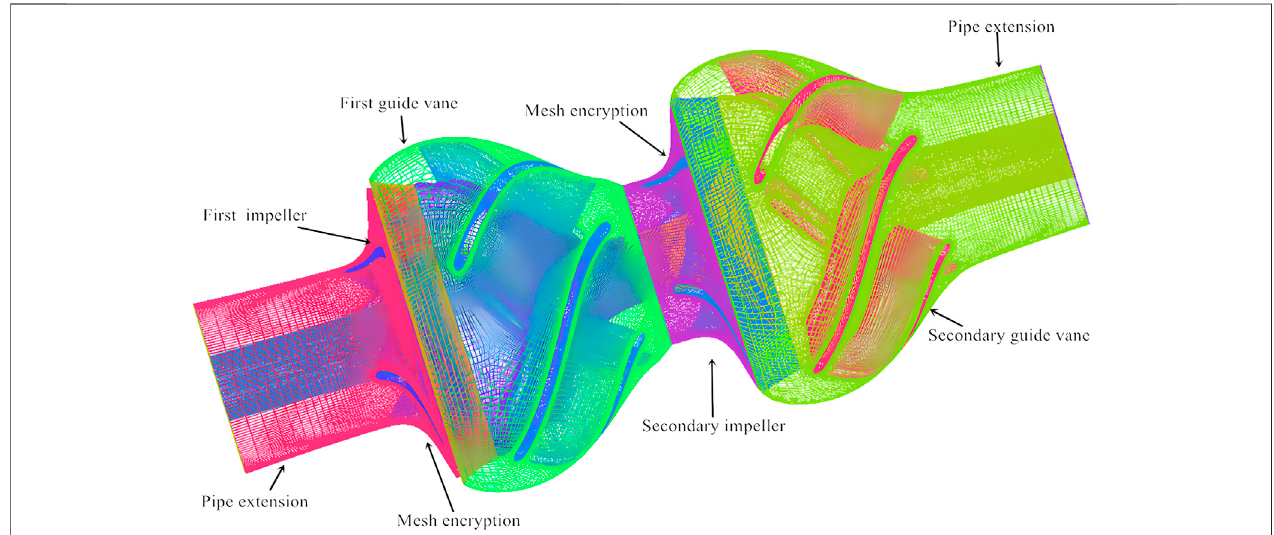
FIGURE 1 | Two-stage deep-sea lifting pump